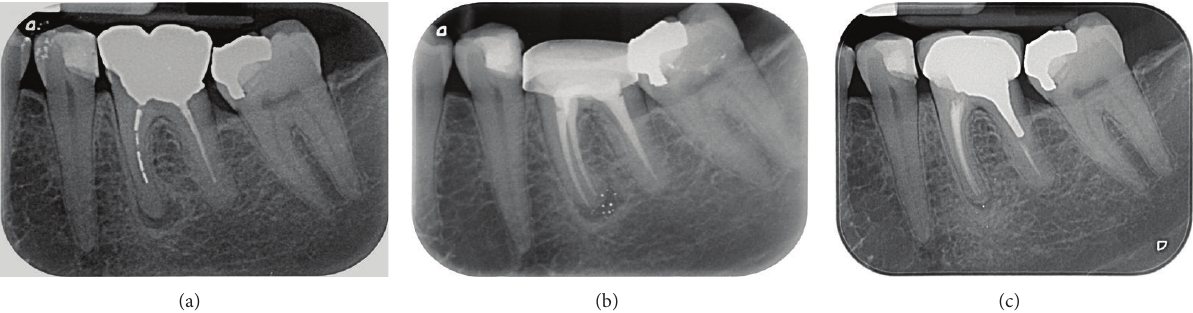
Figure 3: Case classified as healing. (a) Preoperative X-ray of the 36. Patient referred for orthograde retreatment of 36, asymptomatic, with an apical chronic periodontitis on the mesial root. Note the apical radiolucency (PAI = 3 ) and pieces of amalgam in the mesial root. The initial endodontic treatment was performed more than one year ago. (b) Periapical X-ray control immediately after the retreatment: amalgam grains are visible in the periapical region after realisation of the endodontic retreatment. (c) Recall after 4 years: this tooth is classified as “healed”: the amalgam grains seem to have disappeared but there is still a radiolucent area (PAI = 2 ).